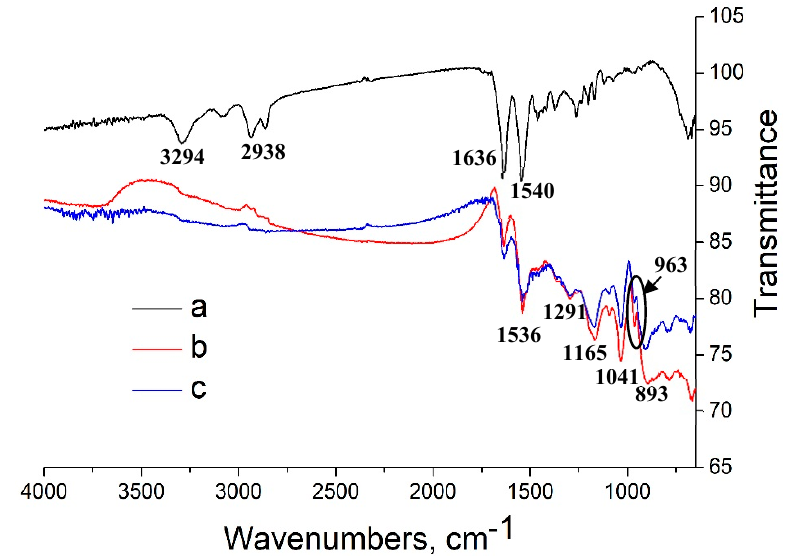
Figure 4. FTIR spectra of PA6-NFsM ( a ) and PPy-PA6-NFsM before ( b ) and after ( c ) extraction of β -lactam antibiotics.